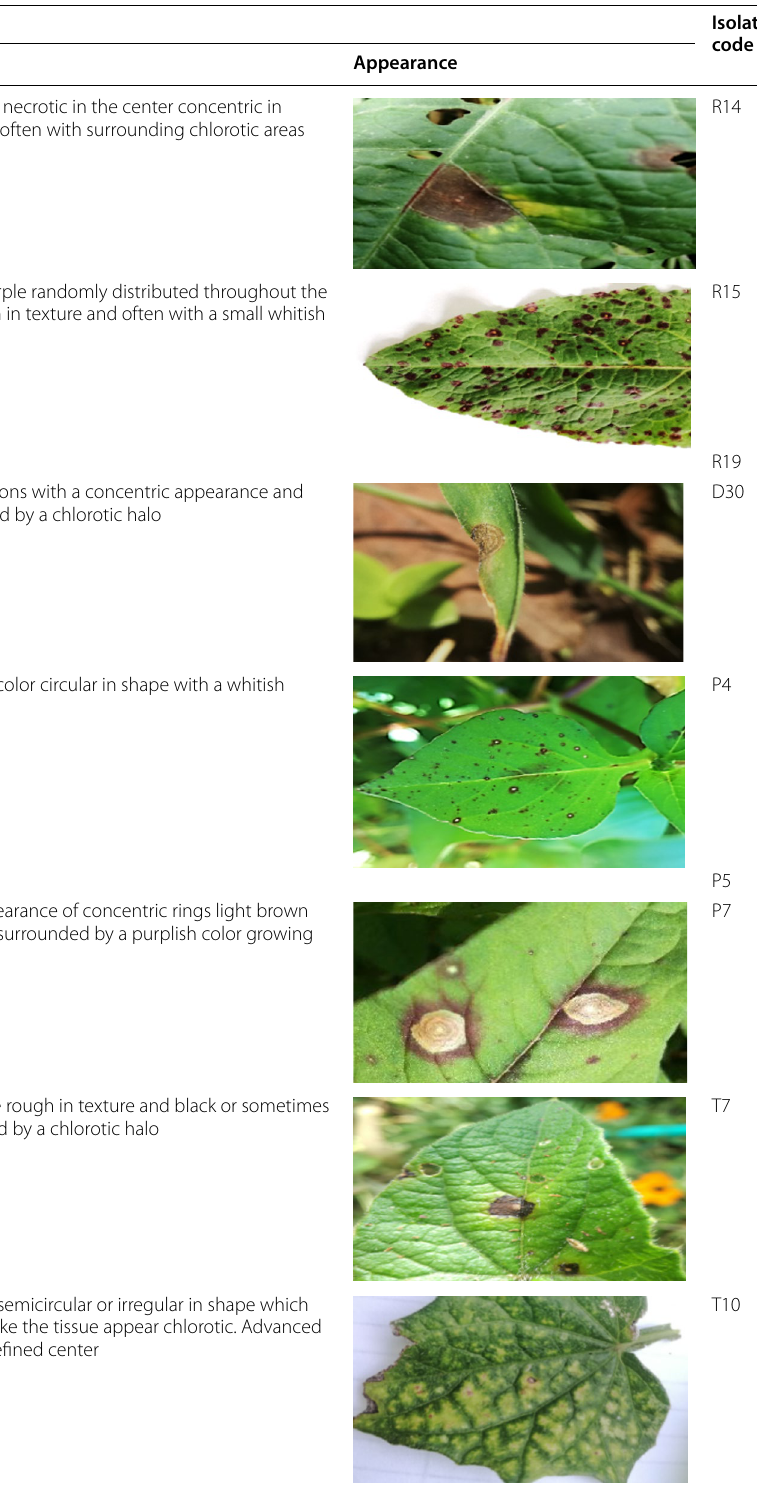
Table 1 Symptomatology observed in the weeds: Rumex crispus , Digitaria horizontalis, Persicaria nepalensis, and Thunbergia alata under field